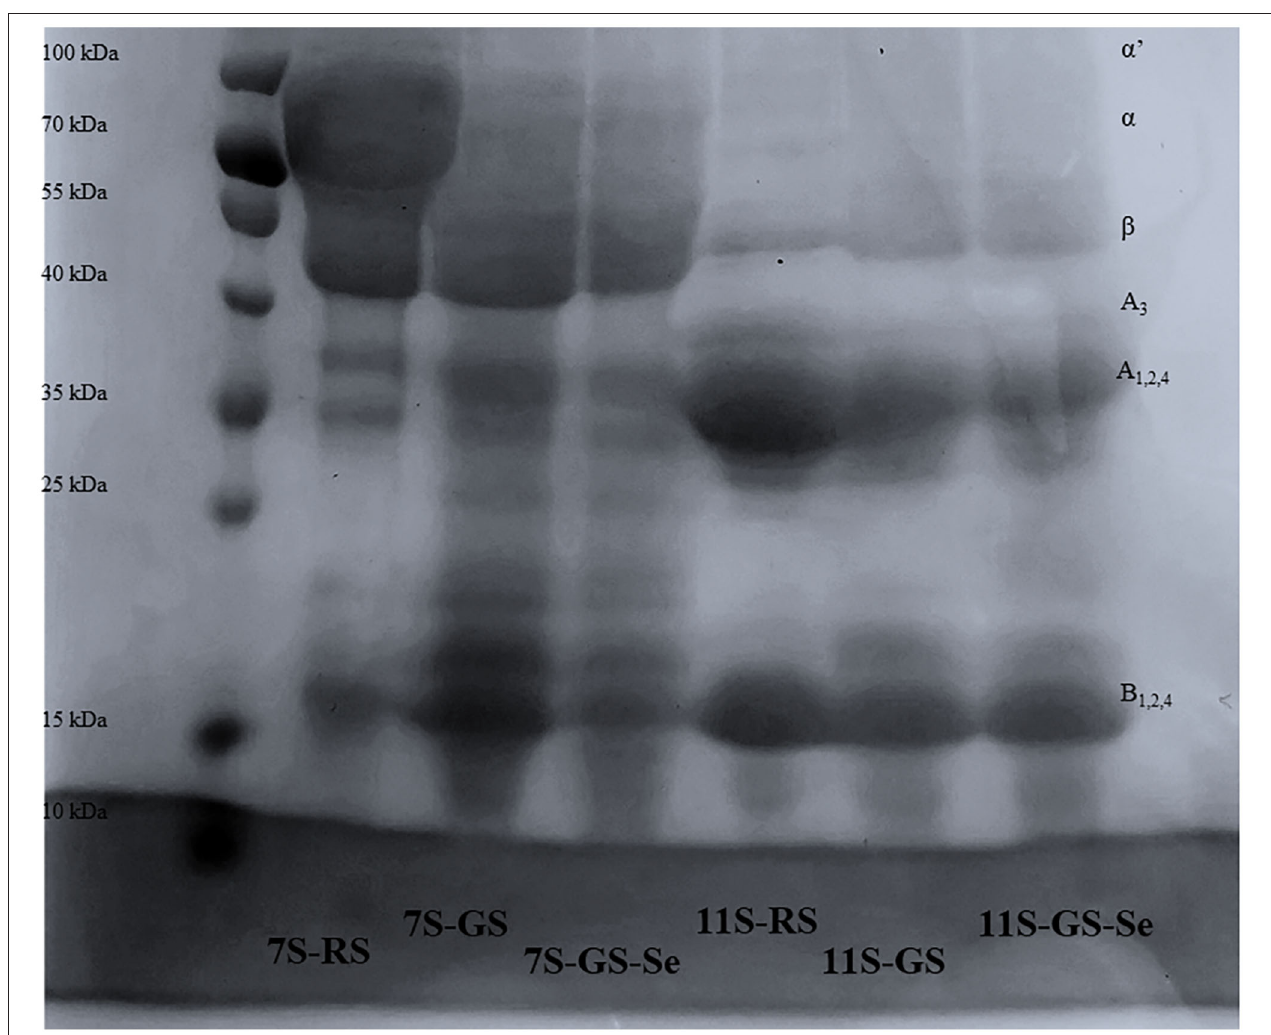
FIGURE 3 | Sodium dodecyl sulfate-polyacrylamide gel electrophoresis patterns of different soybean